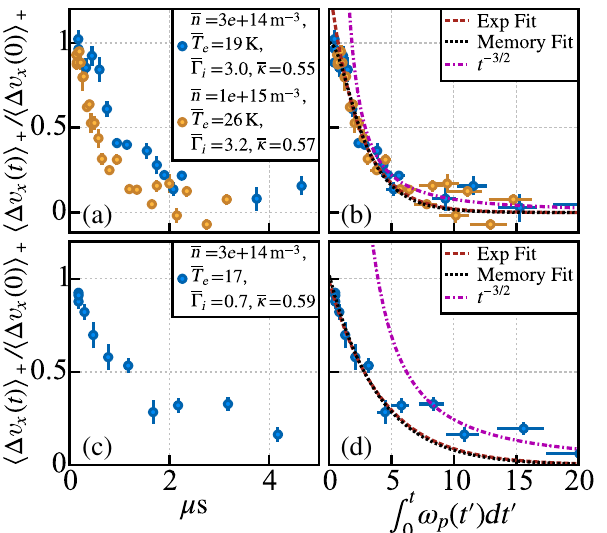
= h Δ v 0 Þi FIG. 4. Early-time behavior of h Δ v x ð t Þi . Lines x ð þ þ indicate memory-function and exponential fits. Data and fits for ¯ Γ 3 . 0 ( ¯ T 19 K ), (b) ¯ κ ¼ 0 . 57 plasmas with (a) ¯ κ ¼ 0 . 55 and i ¼ e ¼ ¯ Γ 3 . 2 ( ¯ T 26 K ), (c) ¯ κ ¼ 0 . 24 and ¯ Γ 2 . 1 and i ¼ e ¼ i ¼ ¯ T 88 K ), and (d) ¯ κ ¼ 0 . 59 and ¯ Γ 0 . 7 ( ¯ T 15 K ). ( e ¼ i ¼ e ¼ Deviation from exponential decay is evident in more strongly coupled